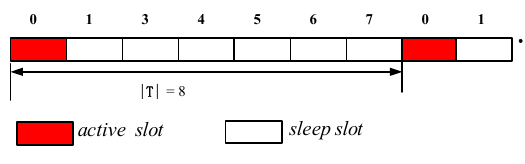
Figure 4. The duty cycle of node.